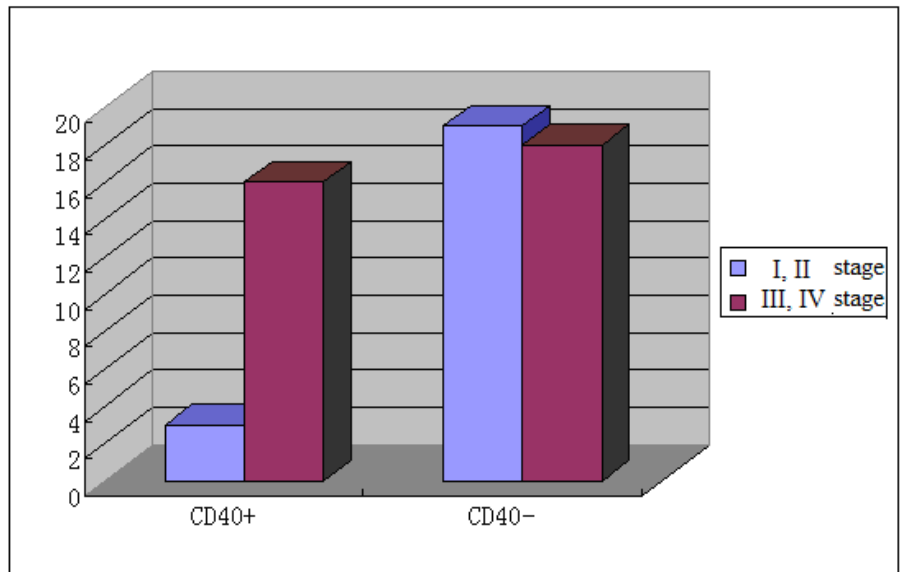
Figure 3. Correlation of CD40 expression with tumor TNM